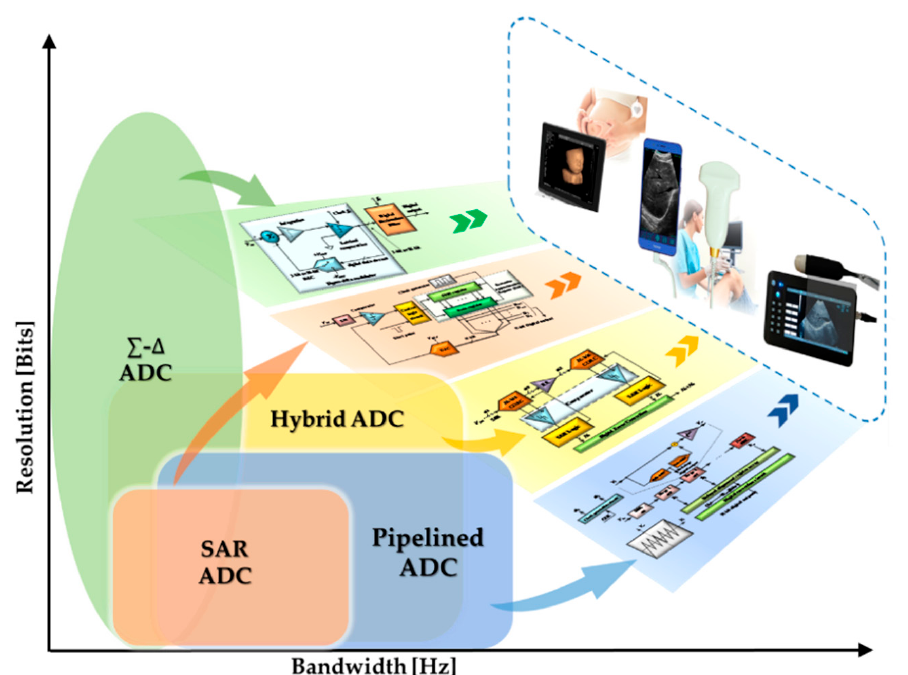
Figure 2. Structures of ADC in miniaturized high resolution UIS.